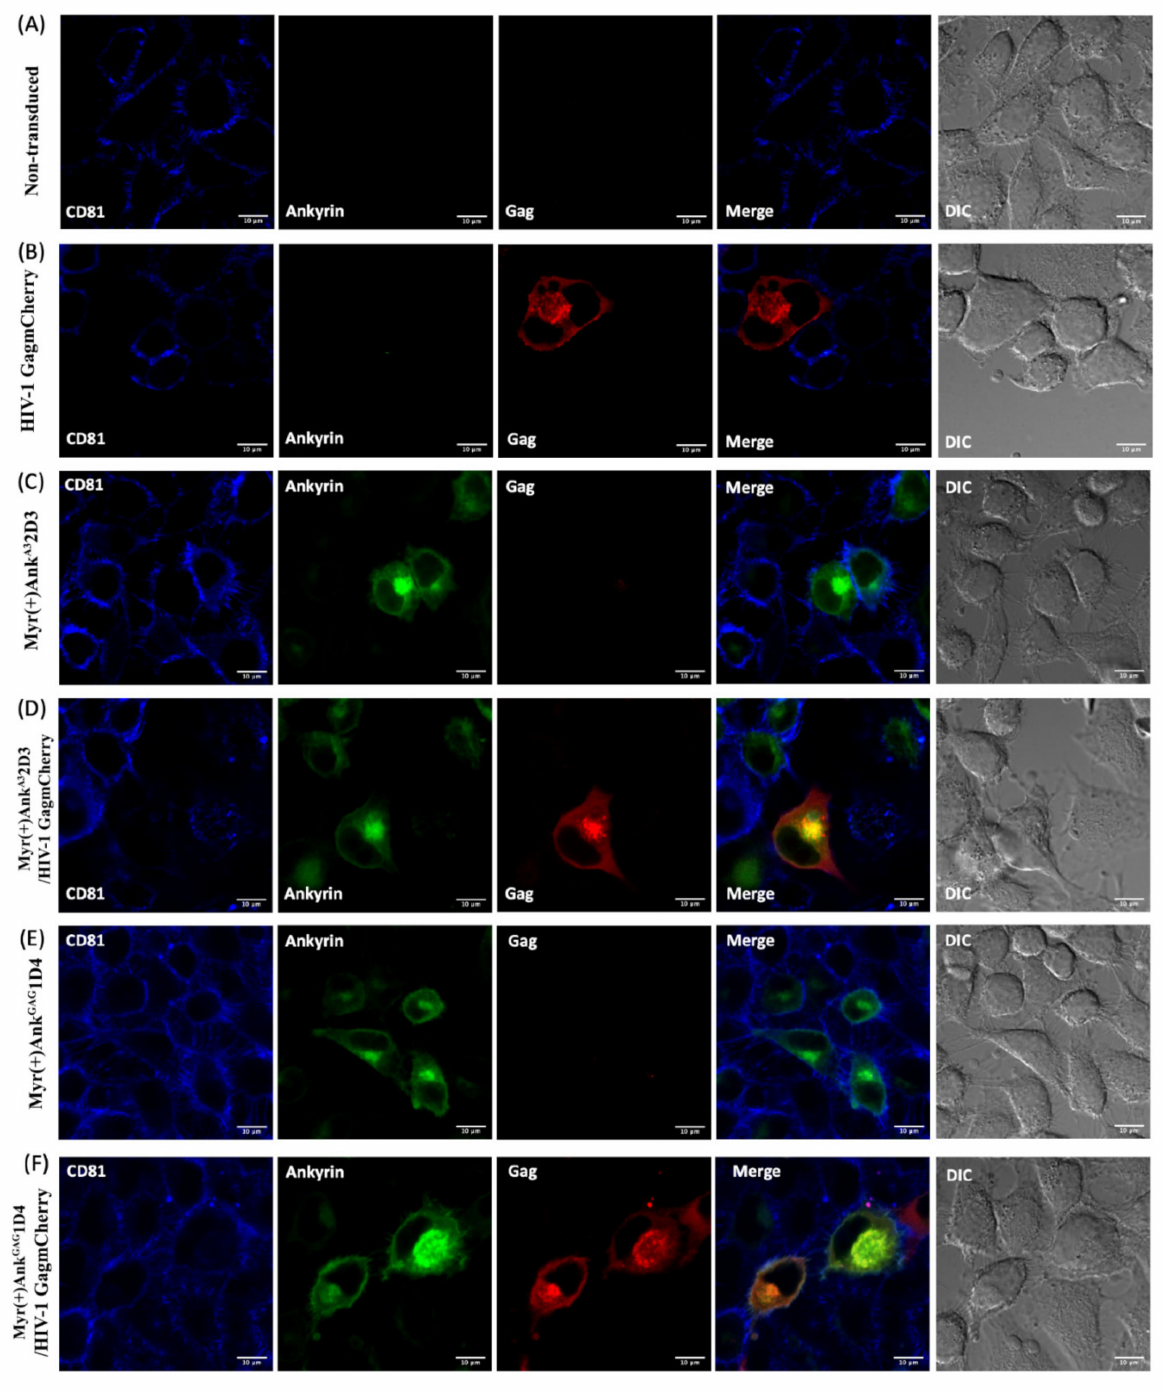
Figure 5. CD81 tetraspanin organisation at the PM during HIV-1 release. HeLa or HeLa cells stably expressing ankyrin (EGFP) were transduced with VSV-G-pseudotyped HIV-1 GagmCherry. After 48 h, cells were harvested, and stained with Pacific Blue™ anti-human CD81. CD81 tetraspanin organisation was visualised under conventional confocal microscopy. ( A ) Non-transduced HeLa cells, ( B ) Transduced HeLa cells, ( C ) HeLa cells stably expressing Myr (+) Ank A3 2D3, ( D ) Transduced HeLa cells stably expressing Myr (+) Ank A3 2D3, ( E ) HeLa cells stably expressing Myr (+) Ank GAG 1D4, ( F ) and transduced HeLa cells stably expressing Myr (+) Ank GAG 1D4. Scale bar: 10 µ m. The image shown in this figure is a representative data of several imaged fields. Blue, green and red represent CD81 tetraspanin, EGFP-tagged ankyrin, and GagmCherry,